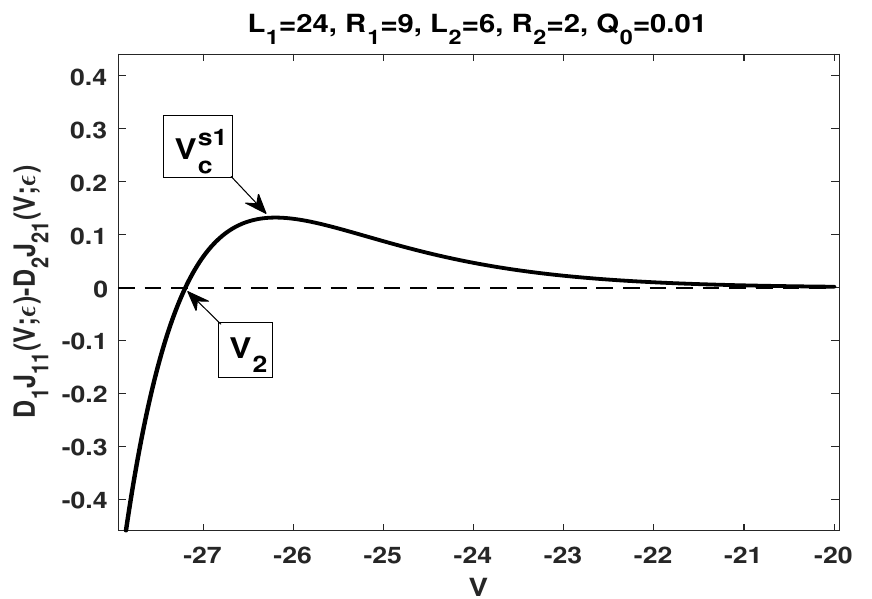
( V ) with D 1 = L 2 D 2 L 1 1,2